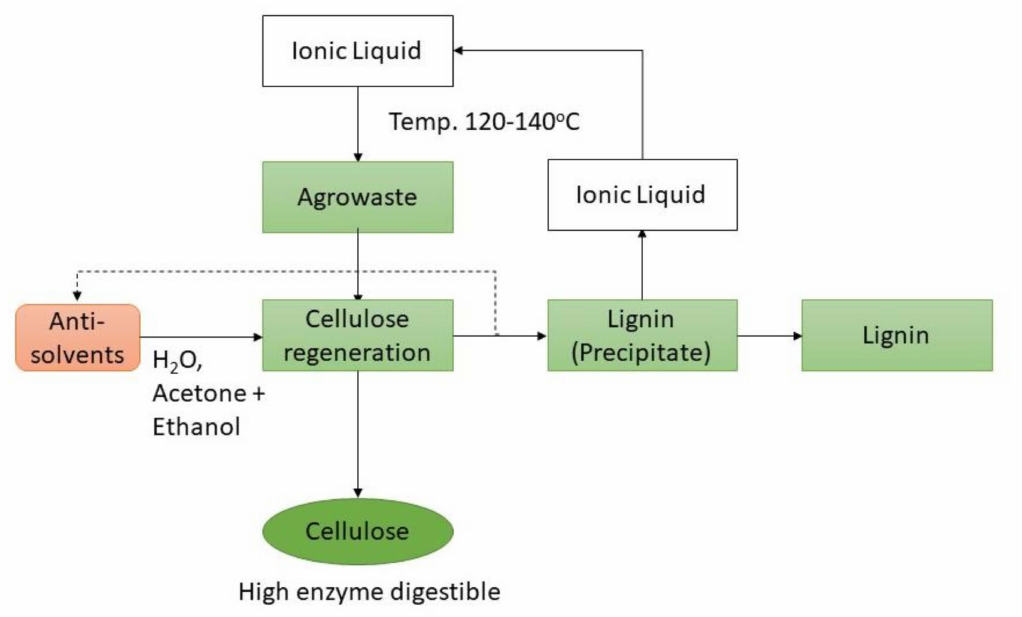
Figure 3. Schematic representation of ionic liquid pretreatment.